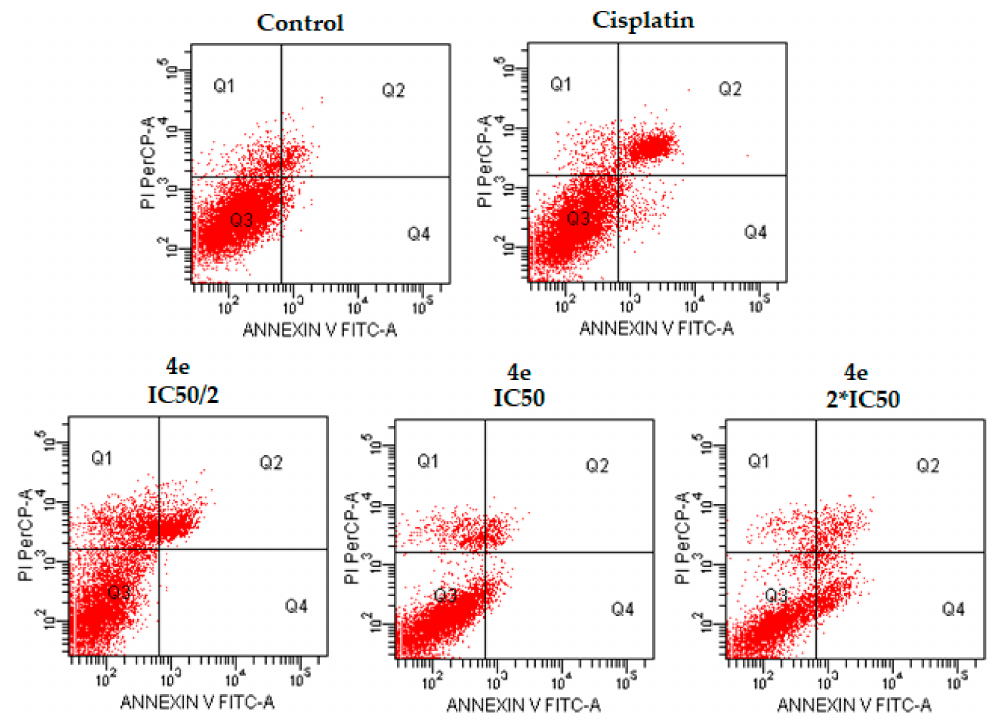
Figure 4. The flow cytometric analysis diagram of compound 4e and cisplatin for C6 cell line. Annexin V-PI analysis in C6 cell line, following a 24 h incubation period of compounds 4e at IC 50 /2, IC 50 , 2 × IC 50 concentrations, which are 0.015, 0.03 and 0.06 mM, respectively, following a 24 h incubation period. An FITC Annexin V method in C6 cell line, following a 24 h incubation period of cisplatin at IC 50 (0.03 mM). A diagram can be divided into four regions that are defined as follows: the percentage of necrotic cells (PI/FITC. +/ − ; Q1); the percentage of late apoptotic cells (Q2; PI/FITC +/+); the percentage of viable cells (Q3; PI/FITC − / − ) and the percentage of early apoptotic cells (Q4; PI/FITC − /+). Percentages of Q1, Q2, Q3, and Q4 of compound 4e and cisplatin were presented in Table 2.